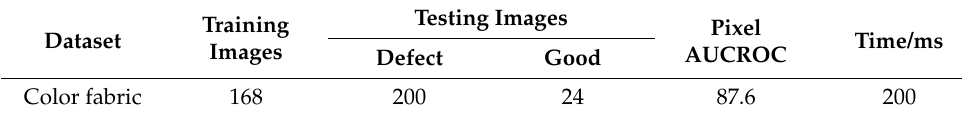
Table 7. Color fabric dataset and inspection